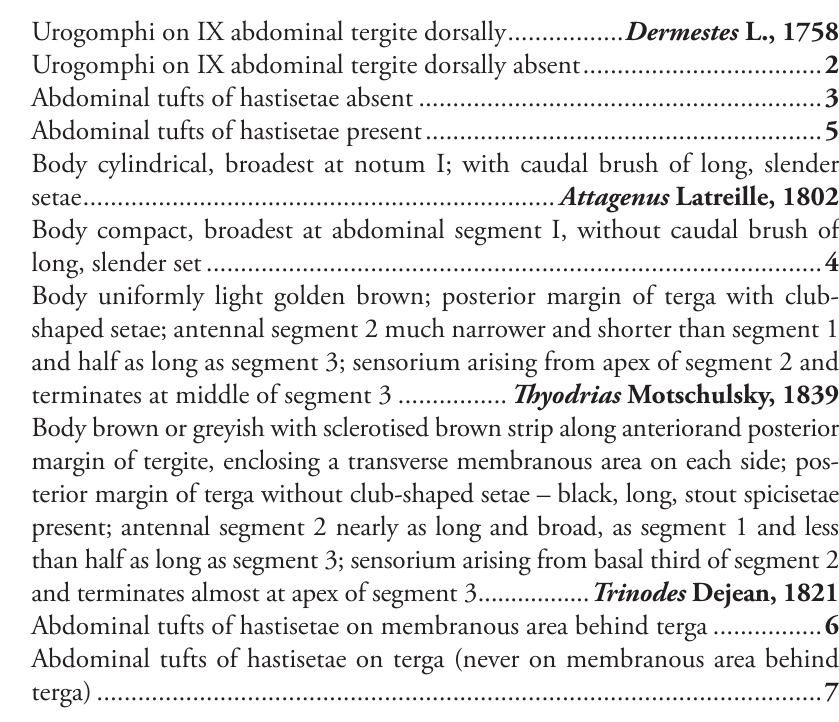
Body uniformly light golden brown; posterior margin of terga with club- shaped setae; antennal segment 2 much narrower and shorter than segment 1